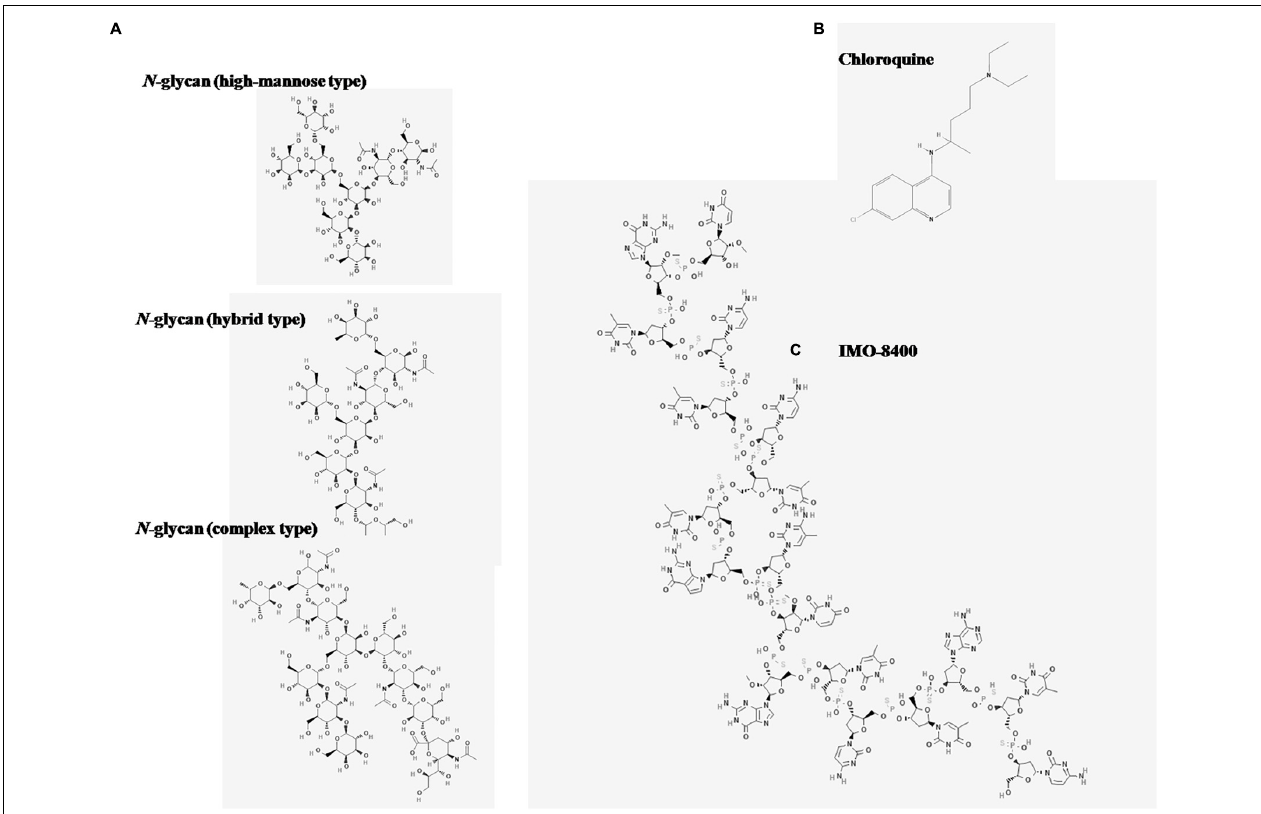
FIGURE 6 | Chemical structures of antagonists of TLR-8 activation. Images were obtained from the National Center for Biotechnology Information. (A) Three major N-glycan types are depicted: High mannose type, PubChem Database. CID = 91852027, https://pubchem.ncbi.nlm.nih.gov/compound/91852027; hybrid type, PubChem Database. CID = 91860397, https://pubchem.ncbi.nlm.nih.gov/compound/91860397; complex type, PubChem Database. CID = 71297682, https://pubchem.ncbi.nlm.nih.gov/compound/71297682. (B) Chloroquine (CQN), PubChem Database. Chloroquine, CID = 2719,